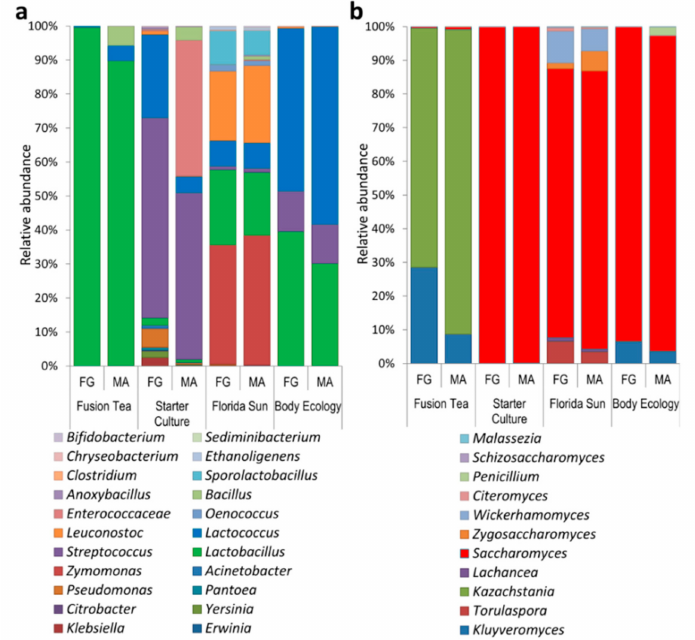
Figure 3. Diversity and relative abundance of dominant bacteria ( a ) and yeast ( b ) genera as identified by metagenomic approach from fresh (FG) and milk-activated (MA)